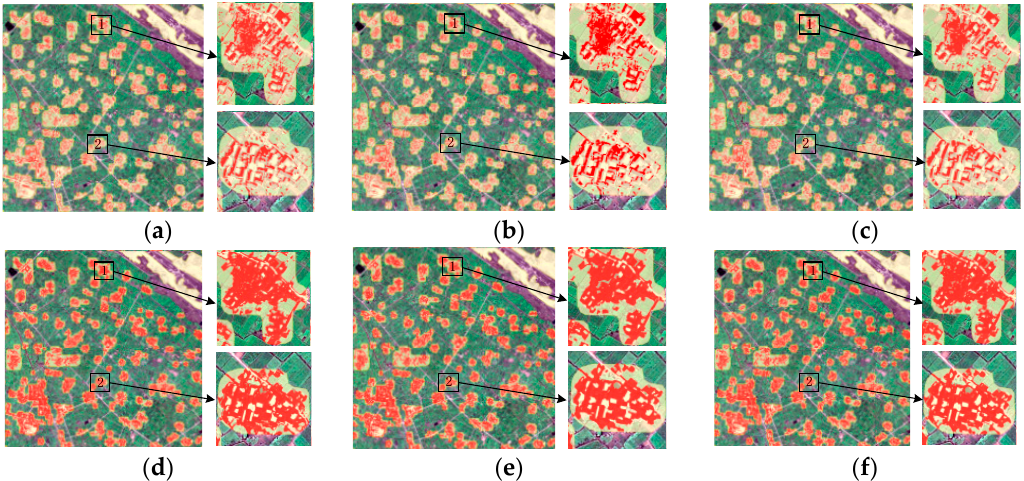
Figure 12. Building results of the spectral-based methods using the QuickBird image: ( a ) Building results of the spectral-based methods using the QuickBird K means _MS_Pix; ( b ) K means _MS_MV; ( c ) K means _MS_Seg; ( d ) SVM_MS_Pix; ( e ) SVM_MS_MV; and ( f )